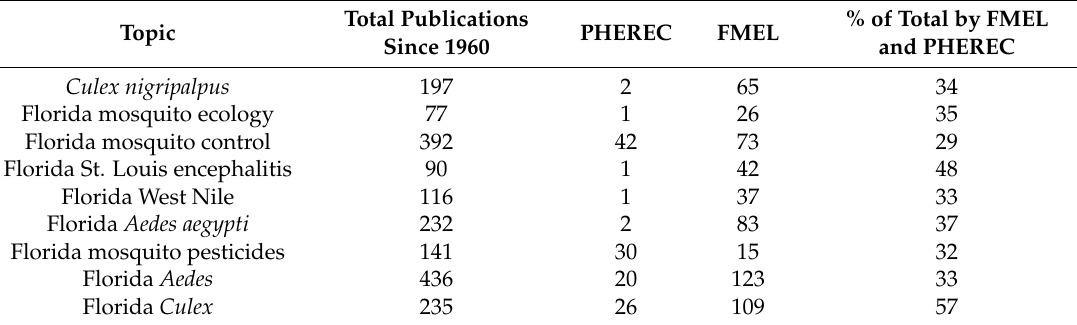
Table 1. Peer reviewed publications from Florida Medical Entomology Laboratory (FMEL) and Public Health and Entomology Research and Education Center (PHEREC) since 1960 on selected Florida mosquitoes, arboviruses, and related subjects with the total number of articles produced on these subjects (Data from PubMed as of 20 July